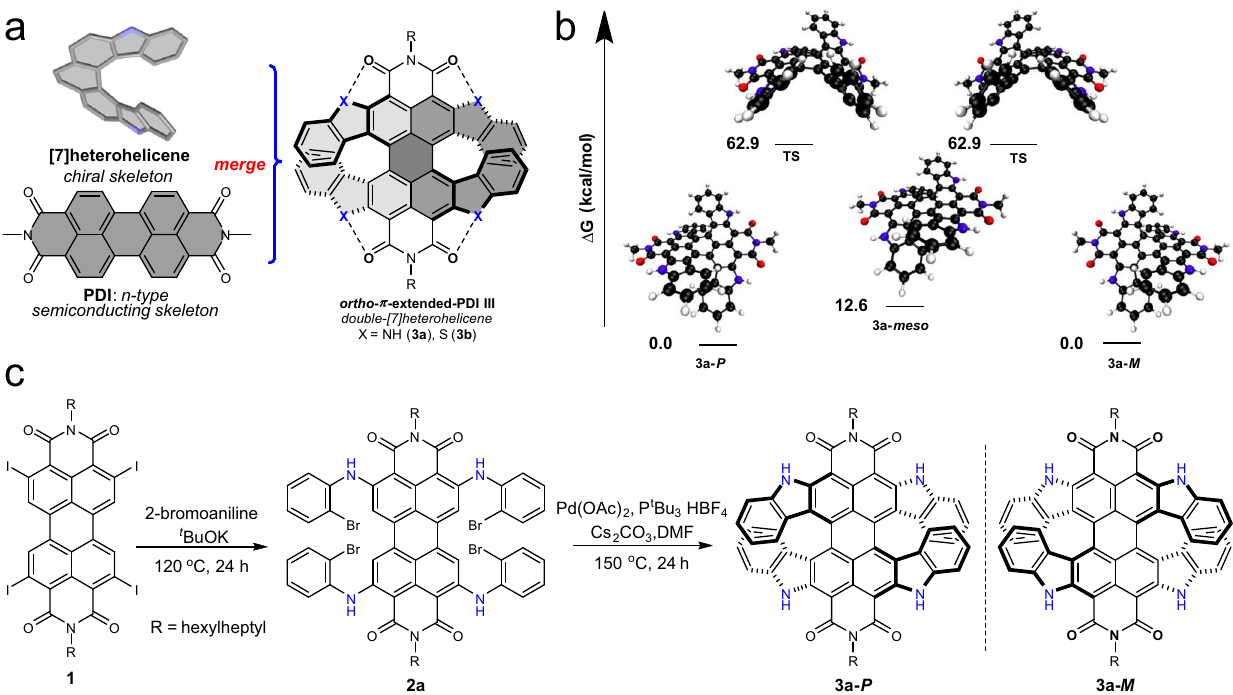
Fig. 1 Molecule design and synthesis. a Schematic representation of the skeleton merging approach. b Potential energy surface of the isomerization process between 3a- P / M and 3a- meso conformations, calculated by DFT calculations at the ω B97Xd/6 – 31 + G(d) level (hexylheptyl groups have been replaced by methyl groups to simplify the calculations, carbon = black, hydrogen = white, nitrogen = blue, oxygen = red). c Synthesis of tetraindole-fused PDIs 3a .